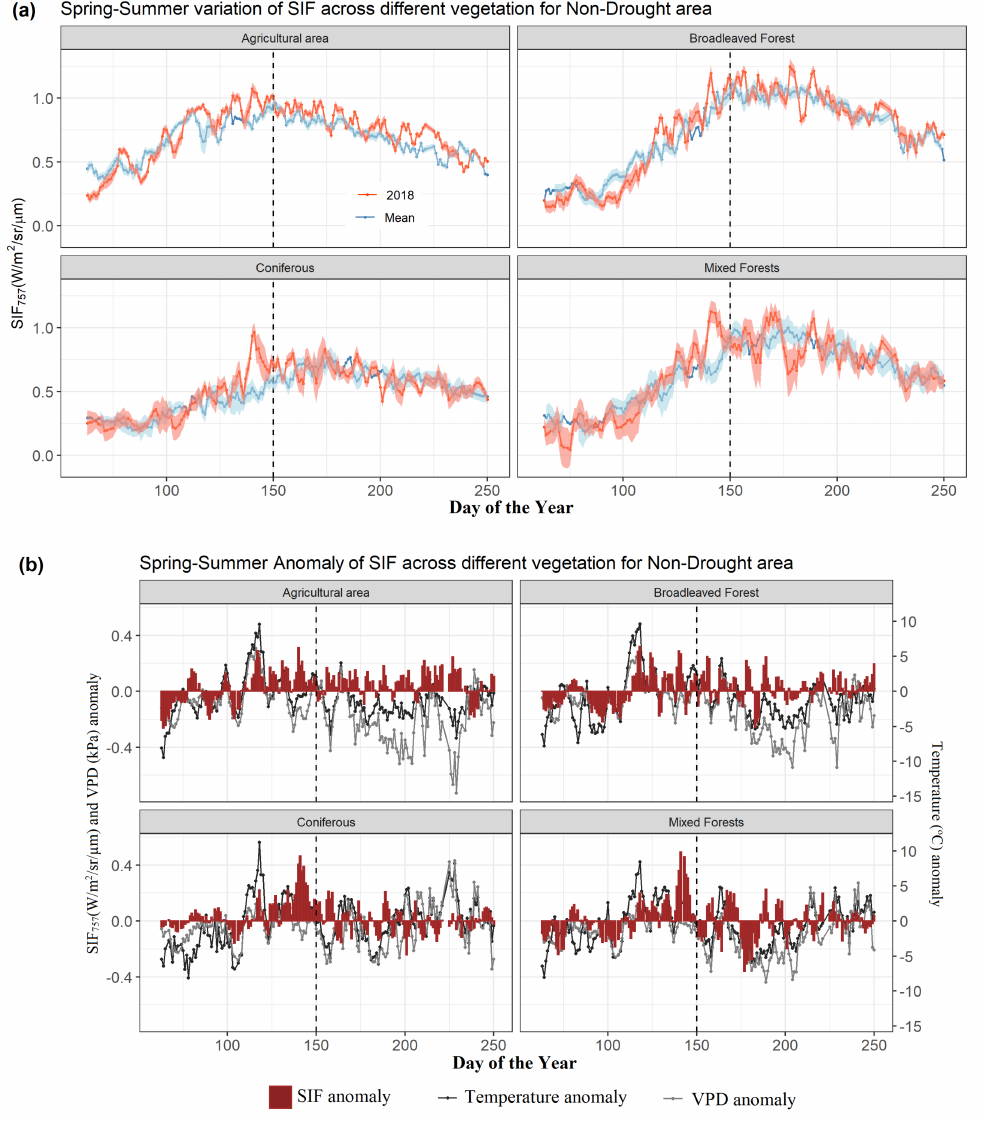
Figure 4. ( a ) Intra-seasonal SIF variability based on 5-day running mean for non-drought areas across di ff erent vegetation types. ( b ) Corresponding SIF anomalies (SIF-Di ff ), and VPD (gray line), and temperature (black line) anomalies. Positive values indicate a surplus of SIF, Temp, and VPD; negative values indicate lower values in comparison to the mean in 2015–2017. Shaded area (light blue for SIF_Mean; red for SIF_2018) in part ( a ) is ± standard error of mean obtained after spatially aggregating the samples. The vertical dashed lines divide the DOY into spring (DOY 60–150) and summer (DOY 151–240) season. Temp-Di ff = Temp_2018–Temp_Mean; VPD-Di ff =